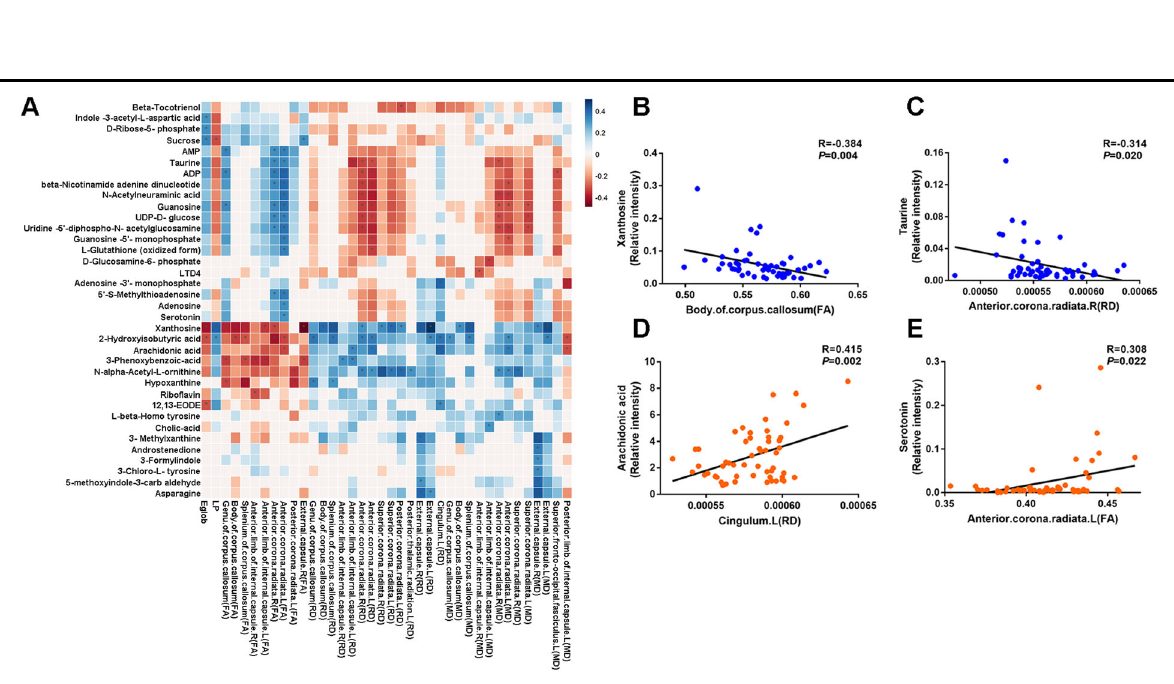
Fig. 5 Correlations between DTI network metrics, the various DTI-derived indices, and the metabonomics characteristics. A Summary of the correlations between DTI network metrics, the various DTI-derived indices, and the metabonomics characteristics. The color indicates the value of the correlation coef fi cient of the corresponding correlation (blue, and red are negative and positive correlations, respectively). Correlation with a two- sided α of <0.05 was considered statistically signi fi cant and marked with an asterisk. B Scatter plot of xanthosine and body of corpus callosum (FA). C Scatter plot of taurine and right anterior corona radiate (RD). D Scatter plot of arachidonic acid and left cingulum (RD). E Scatter plot of serotonin and left anterior corona radiate (FA). AMP adenosine 5 ’ -monophosphate, ADP adenosine diphosphate, LTD4 leukotriene D4, 12, 13-EODE 12, 13- epoxyoctadec-97-enoic acid, R Pearson ’ s correlation coef fi